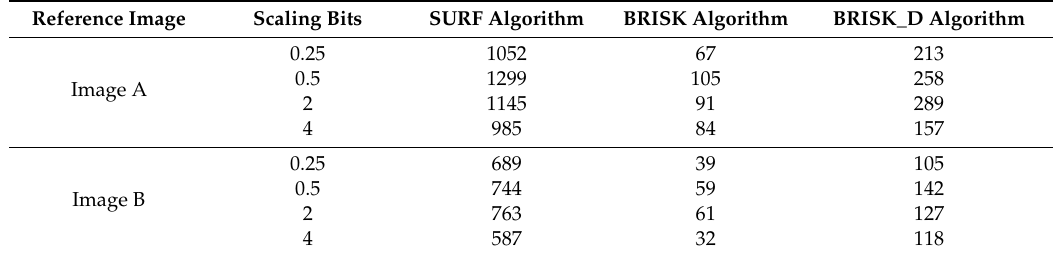
Figure 8. The experimental result about registering Image A with its own reducing to 1/2. Table 3. The correct matching number of reference image after scaling.